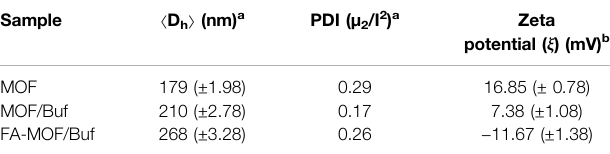
TABLE 1 | Hydrodynamic ( (cid:3) D h (cid:4) ), polydispersity index ( μ 2 /I 2 ), and zeta potentials ( ξ ) of the MOF NPs